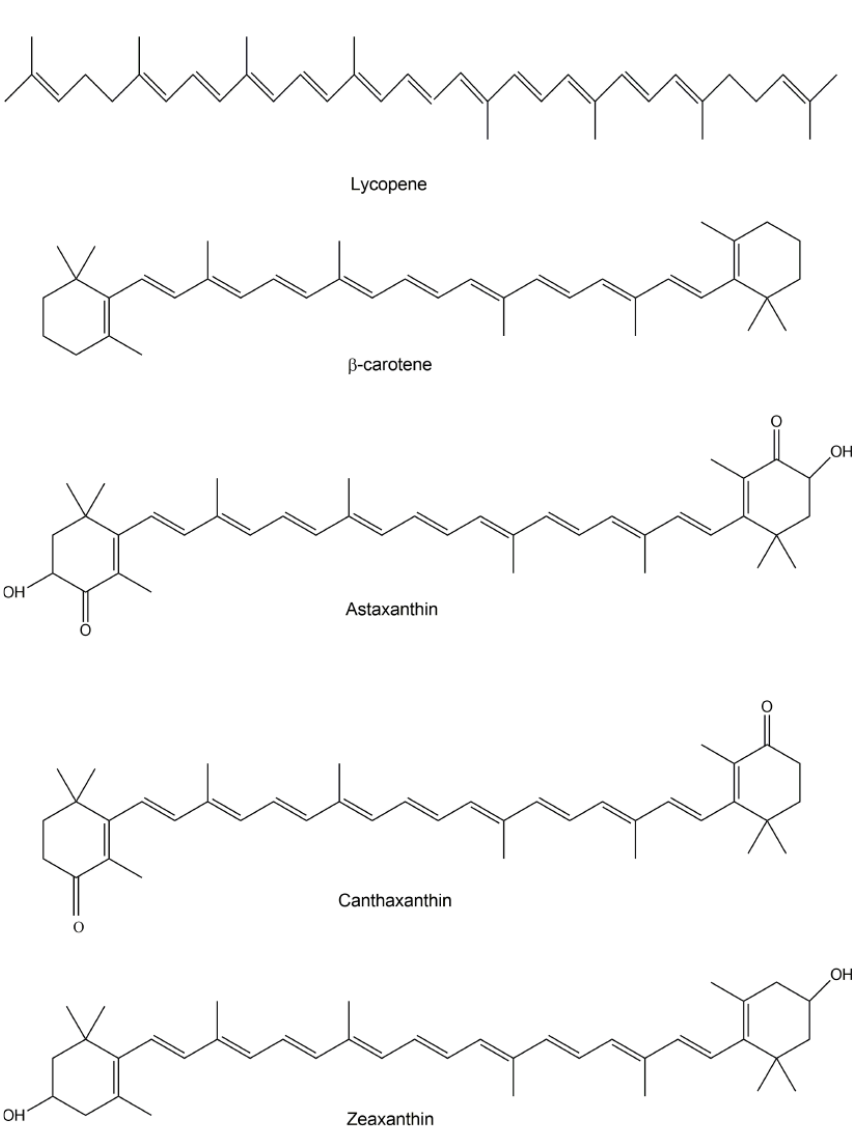
Figure 1. Structure of representative carotenoids.